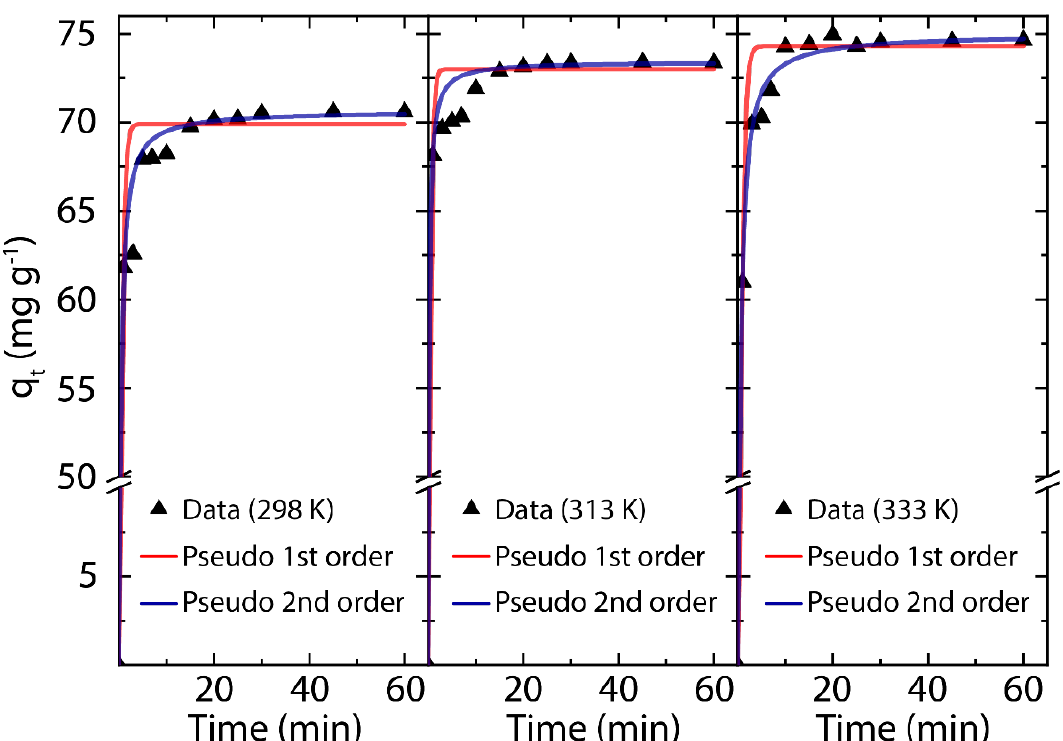
Figure 4. Adsorption kinetics of MB on rGO as a function of contact time (up to 60 min) and different temperatures (298, 313, 333 K).